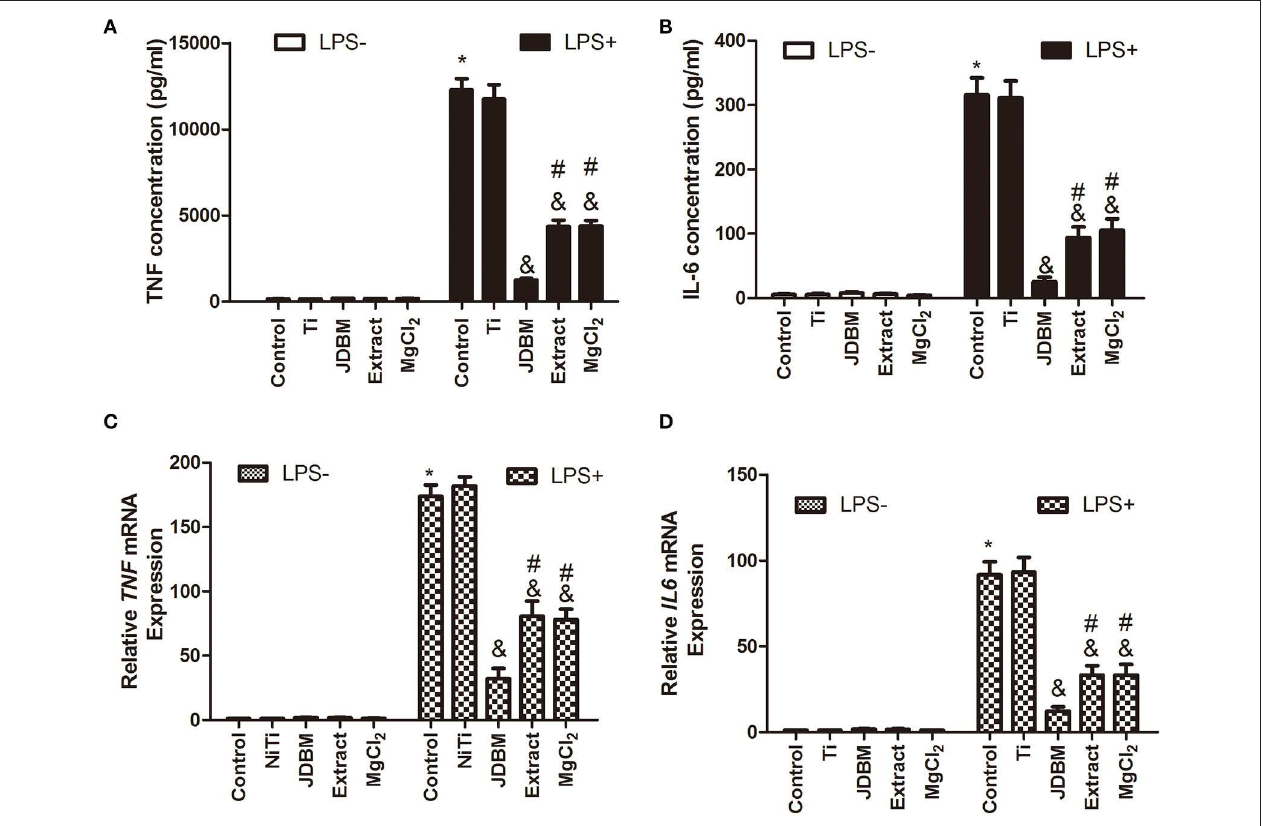
FIGURE 1 | Effects of JDBM, extract, and MgCl 2 on the expression of pro-inflammatory cytokines in THP-1 cell-derived macrophages. THP-1 cell-derived macrophages were cultured with JDBM, Ti, extract, and MgCl 2 for 1h prior to addition of LPS for another 6 or 24h. The protein expression of TNF (A) and IL-6 (B) in supernatants was determined at 24h by ELISA. The mRNA expression of TNF (C) and IL-6 (D) was analyzed with qPCR at 6h. & P < 0.05 vs. LPS-induced control group; * P < 0.05 vs. control group; # P < 0.05 vs. LPS + JDBM group. JDBM, Mg-2.1Nd-0.2Zn-0.5Zr alloy; LPS, lipopolysaccharide; TNF, tumor necrosis factor; IL,